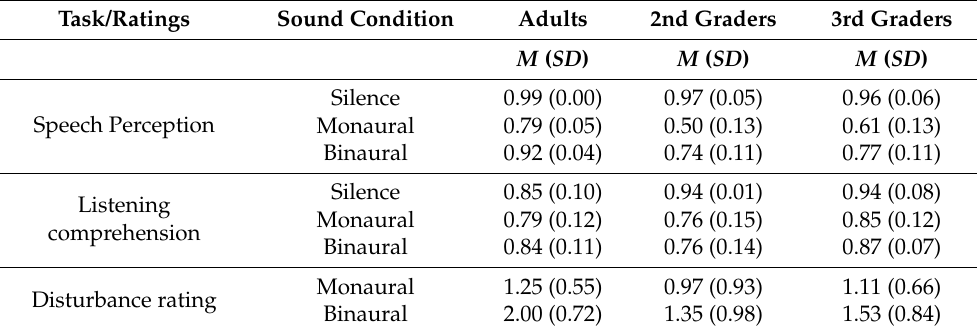
Figure 3. Mean difference scores for speech perception ( a ) and listening comprehension ( b ) with respect to age group and sound condition. Error bars denote standard errors of the mean. Table 1. Mean proportion correct scores for speech perception and listening comprehension, and mean disturbance ratings for Experiment 1 as a function of sound condition and age group (standard deviation in